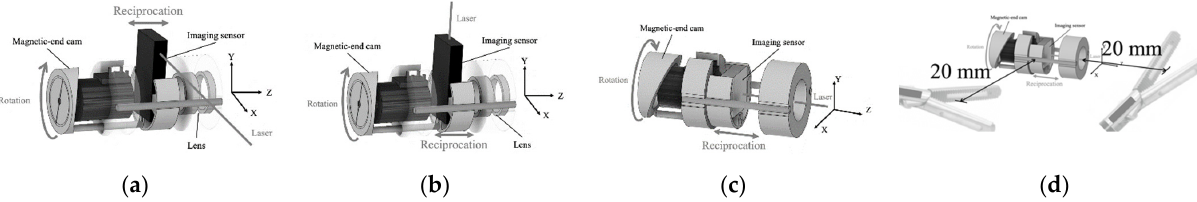
Figure 3. An experimental setup to measure the device’s motion accuracy: ( a ) top view and ( b ) side view. Figure 4. Accuracy of device motion was measured independently for the ( a ) x-axis, ( b ) y-axis, and ( c ) z-axis. The metal effect was measured with the dimensions shown in ( d ).